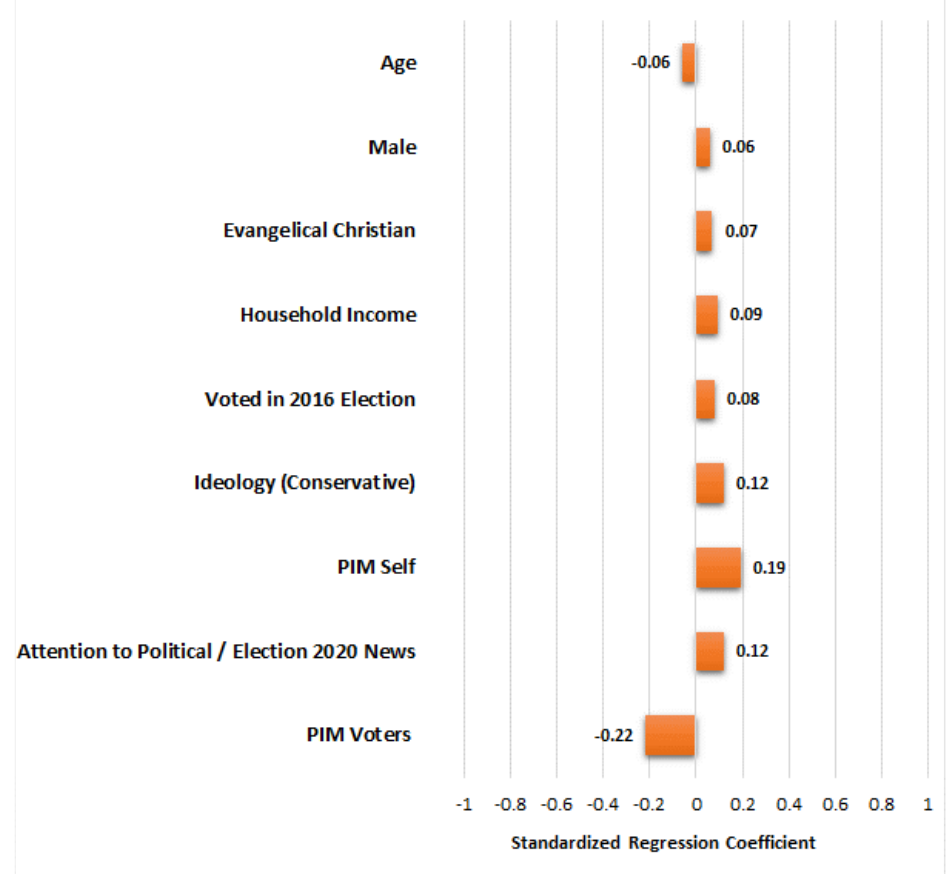
Figure 2. Significant predictors of satisfaction with electoral democracy (standardized regression coefficients reported; see Supplementary Materials for full OLS regression model of